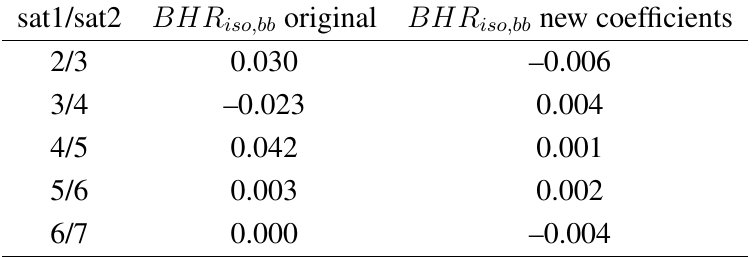
Table 1. Mean surface albedo difference between pair of two consecutive Meteosat satellites before (original) and after (new coefficients) correction of spectral conversion